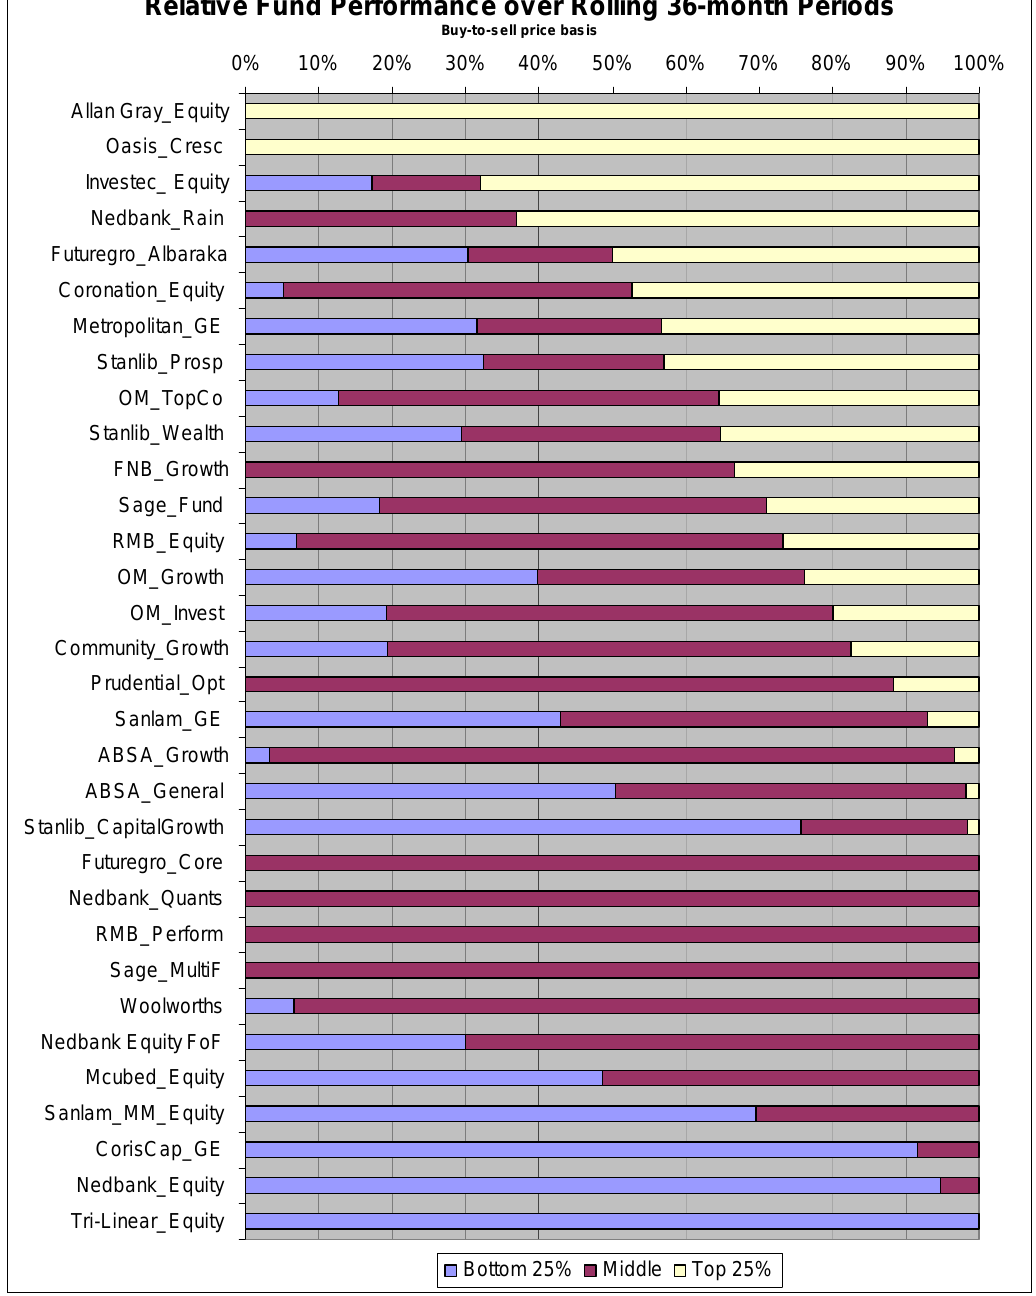
Figure 1: Quartile ranking of actively managed funds over rolling 36 month investment